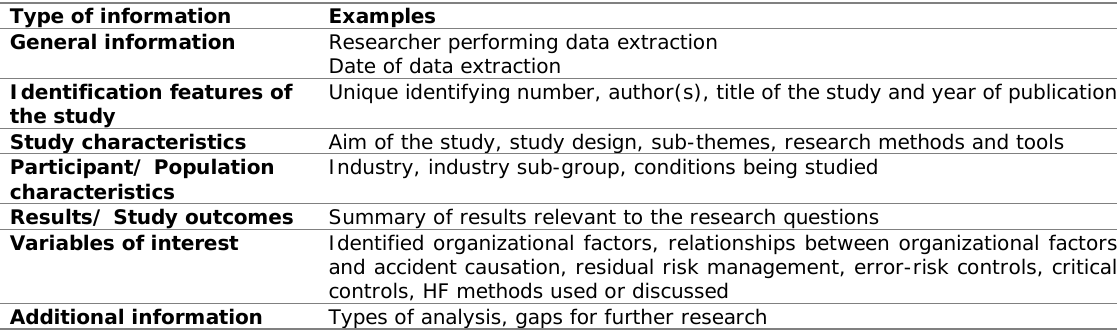
Table 2. Example of data items to be included in data